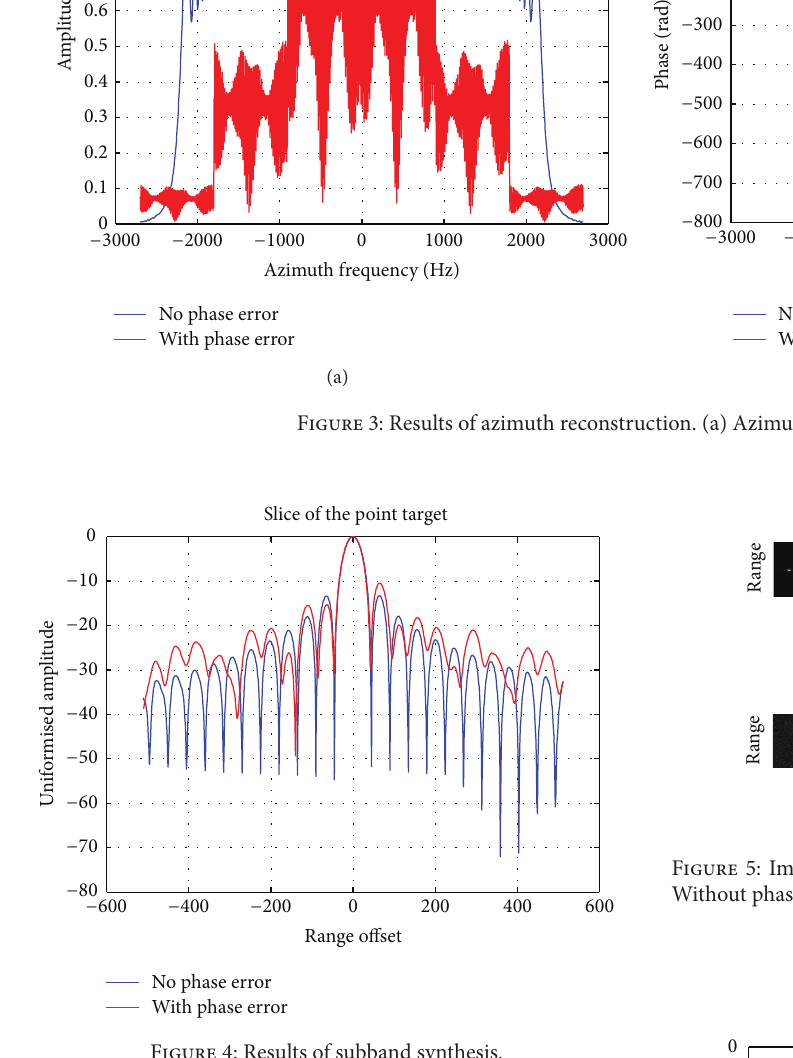
Figure 4: Results of subband synthesis.